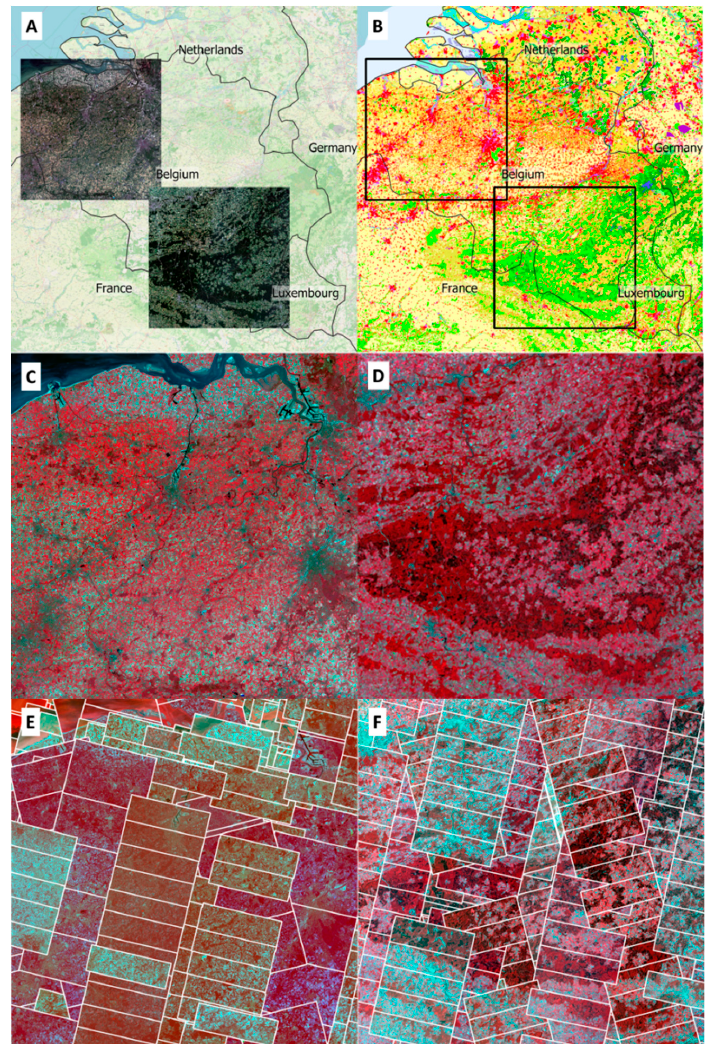
Figure 3. Belgian Sentinel ‐ 2 (S2) tiles and PlanetScope (PS) scenes: ( A ) the two selected S2 tiles over Belgium in true color (B4, B3, and B2); ( B ) land cover for the same area (Corine Land Cover 2018); ( C , D ) zoom on S2 tiles in false color (B8a, B4, and B3); and ( E , F ) the two corresponding PS mosaics in false color (NIR, R, and G). The white lines indicate scene boundaries and highlight the radiometric inconsistencies between PS strips.